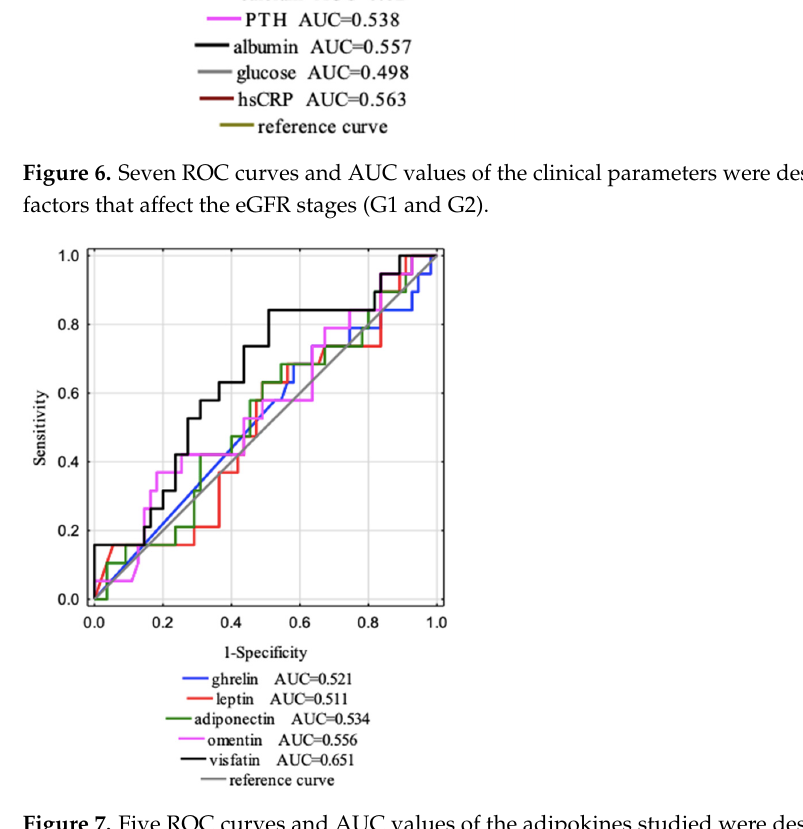
Figure 7. Five ROC curves and AUC values of the adipokines studied were designed to distinguish factors that affect the eGFR stages (G1 and G2).